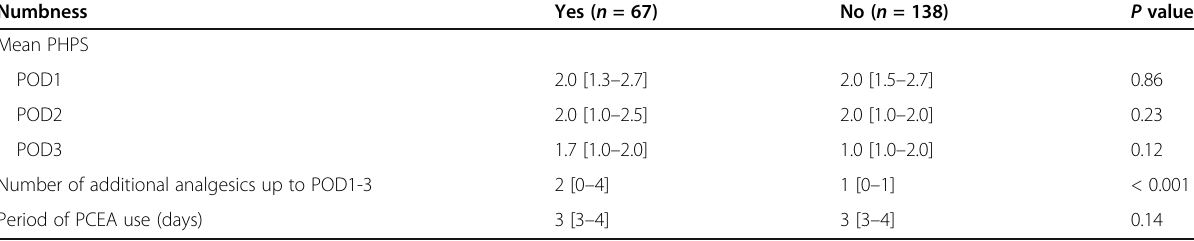
Table 2 Numbness in the lower extremities and analgesic effects Numbness Yes ( n = 67)